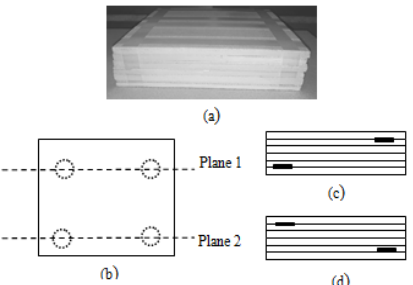
Figure 4. ( a ) Picture and schematic of ( b ) the top view, with the embedded disks indicated, ( c ) the cross-sectional side view at Plane 1, and ( d ) the cross-sectional side view at Plane 2.